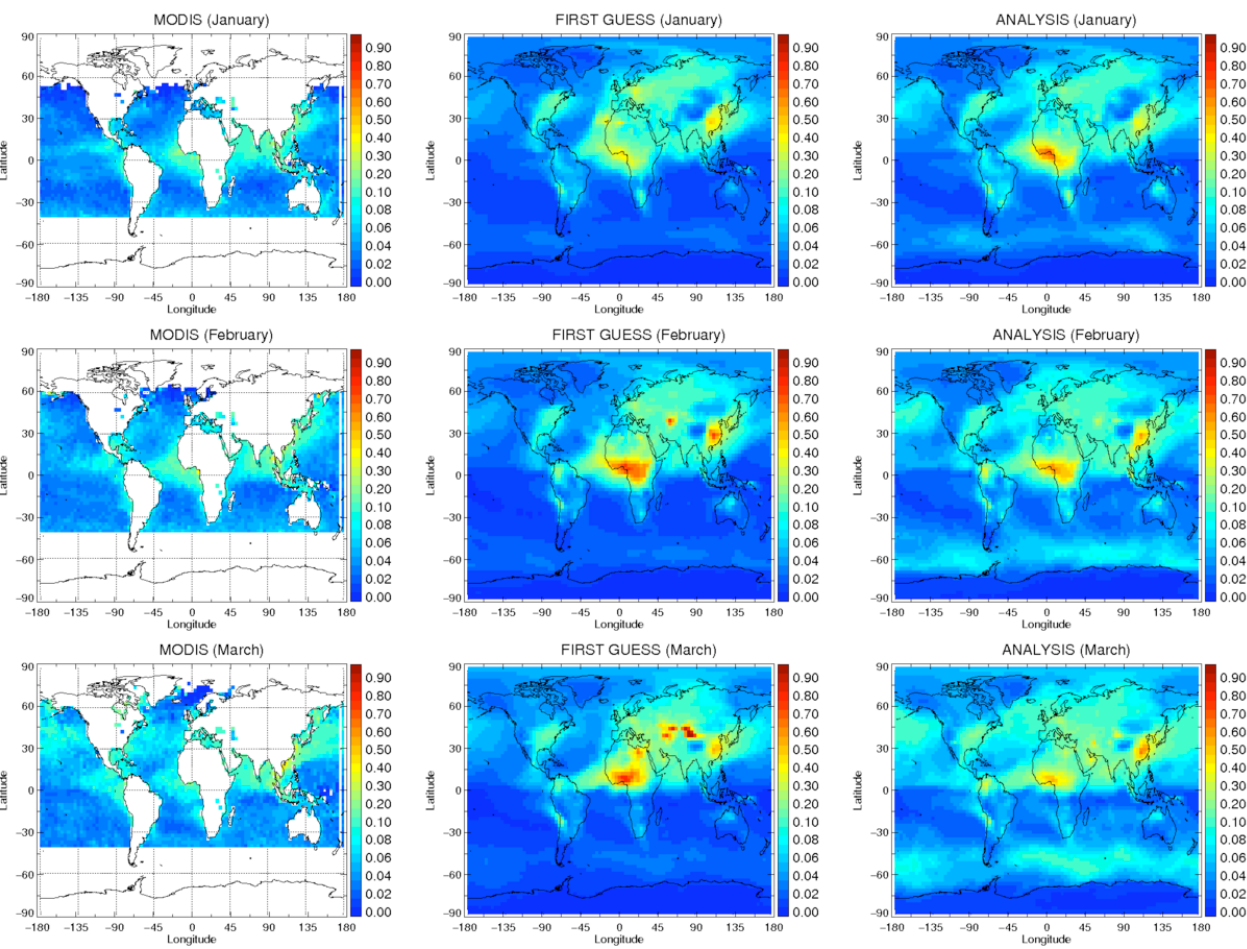
Fig. 6. Same as Fig. 5 but for fine mode AOD.